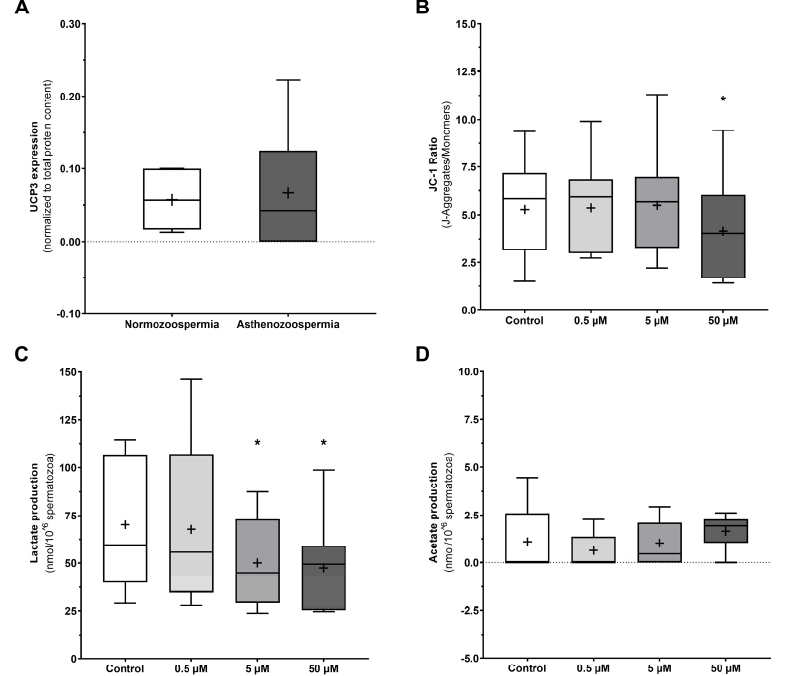
Figure 6. UCP3 expression, mitochondrial membrane polarization, and metabolic profile of human spermatozoa. ( A ) UCP3 relative expression in spermatozoa from normozoospermic versus astheno- zoospermic men. ( B ) Evaluation of mitochondrial membrane potential using the JC-1 dye after inhibition of UCPs by increasing concentrations of genipin (0.5, 5, and 50 µ M) for 3 h. ( C ) Lactate and ( D ) acetate production by human spermatozoa after UCPs inhibition by increasing concentrations of genipin (0.5, 5, and 50 µM) for 3 h. Results are expressed as Tukey’s boxplot (median, 25th to 75th percentiles ± 1.5 IQR). + − Represents group average. Significantly different results are expressed as: * − Relative to the control